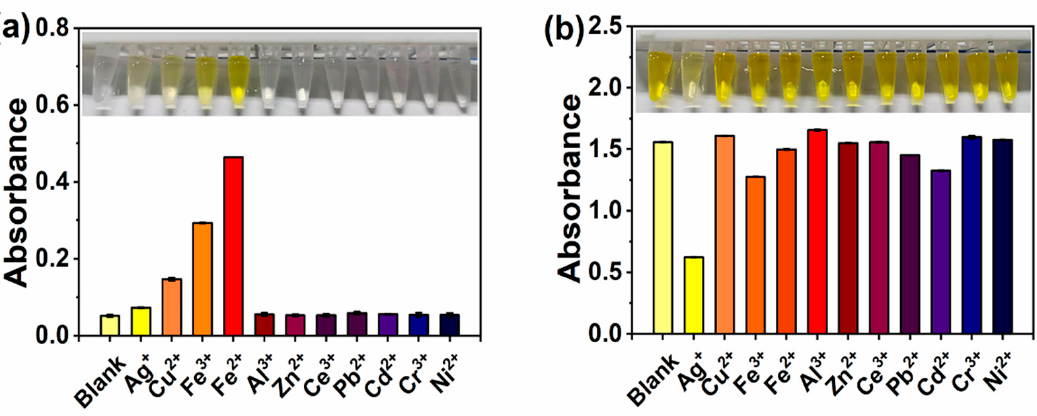
Figure 1. Effects of metal ions on the catalytic activity of AuNCs using the TMB–H 2 O 2 system with two H 2 O 2 concentrations of 100 μ M ( a ) and 10 mM ( b ). Insets are photos of samples of different reaction systems under visible light.